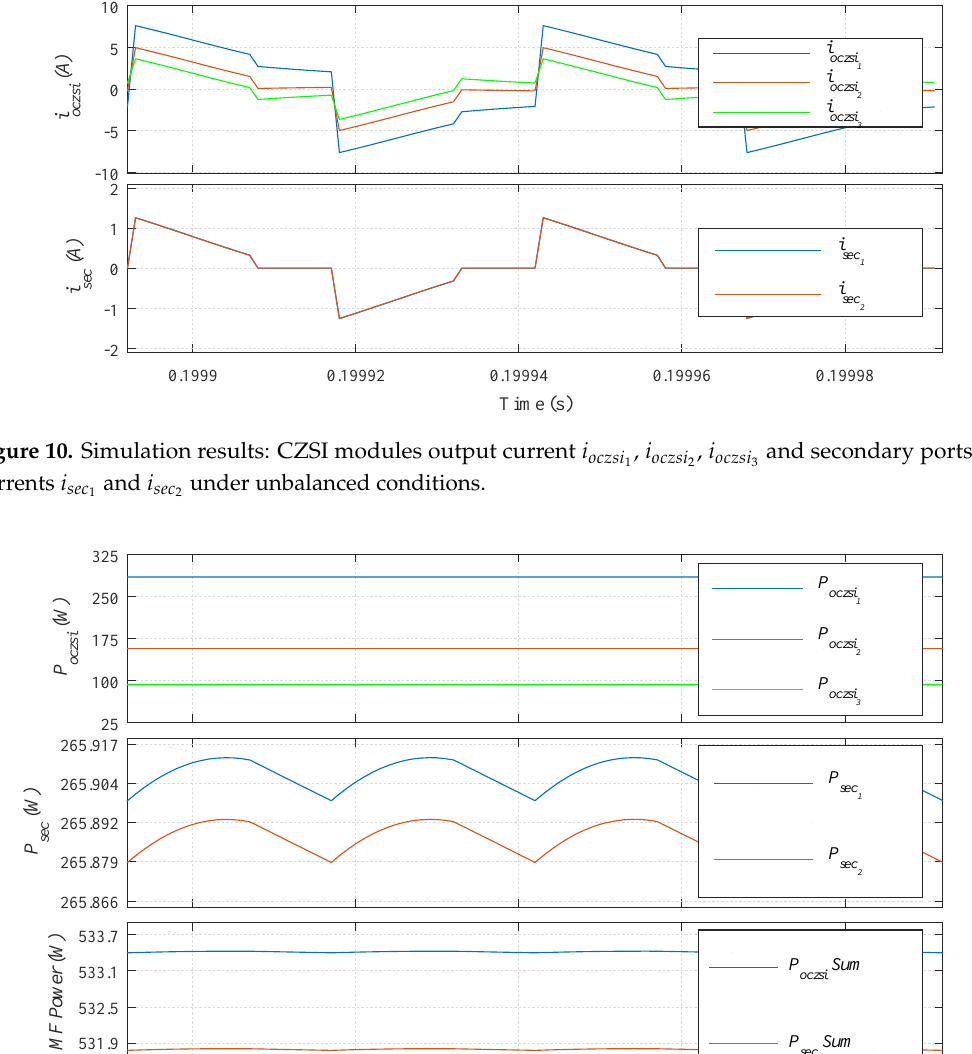
Figure 11. CZSI simulation results: Average power in primary ports and average power in secondary ports under unbalanced power